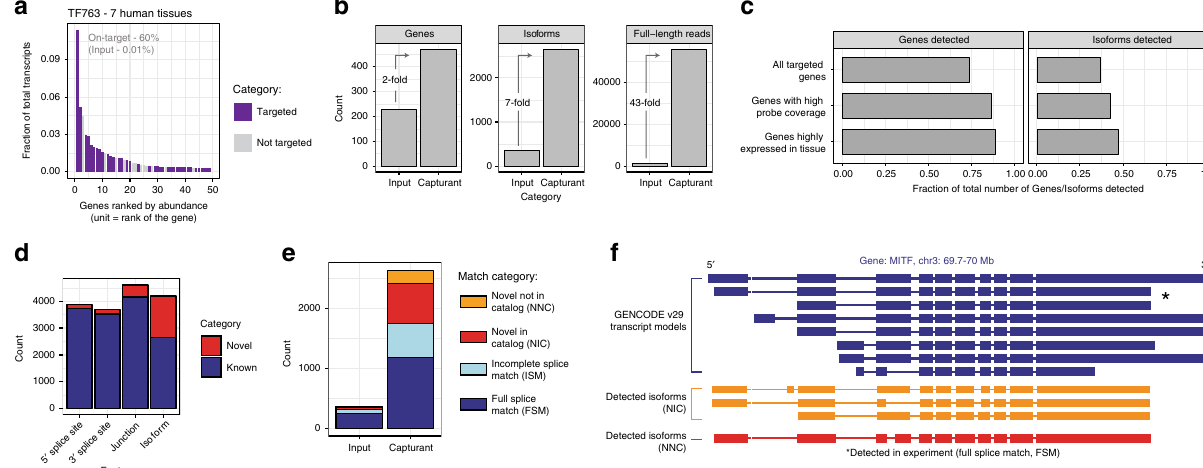
Fig. 4 Full-length transcription factor isoforms across diverse human tissues. a Rank abundance bar plot for cDNA enriched for human TFs. Only the top 50 most abundantly expressed genes are shown. Each bar corresponds to a single gene, colored by whether that gene is targeted (purple) or not targeted (gray). Abundances as shown on the y -axis are computed by dividing the number of full-length reads mapped to the gene by the total number of full-length reads. On-target rates for input and capturant are shown. b Gains in coverage of target genes upon enrichment. Increases in number of genes, isoforms, and full-length reads are shown. Data used to generate these numbers used an equal number of full-length raw reads that were subsampled from the unenriched (input) or enriched (capturant) cDNA. c Fraction of all GENCODE genes and transcripts detected in the capturant. A gene is considered detected if at least one full-length read is detected for that locus. Isoforms are considered detected if the full set of junctions are identical between the GENCODE-annotated and sequenced transcript. The fraction detected was also computed for sets of genes for which there was higher probe set representation of the gene (1 TPM or higher) and genes for which there was evidence of expression in the tissues interrogated (10 TPM or higher). d Fraction of novel splice sites, junctions, and full-length isoforms in the TF enrichment experiment. Unique splice sites and junctions are only counted once. The 5 ′ splice site corresponds to the splice donor and the 3 ′ splice site corresponds to the splice acceptor. SS, splice site. e Proportions of known and novel isoforms. Known isoforms are further divided by completeness. Novel isoforms are further divided by whether all splice sites are found in GENCODE (novel in catalog, NIC) or if the isoform contains a novel splice site (novel not in catalog, NNC). Match categories are de fi ned by the isoform annotation tool SQANTI. g Example of isoforms from the gene MITF identi fi ed from the TF763 capture experiment. Source data are available in the Source Data fi